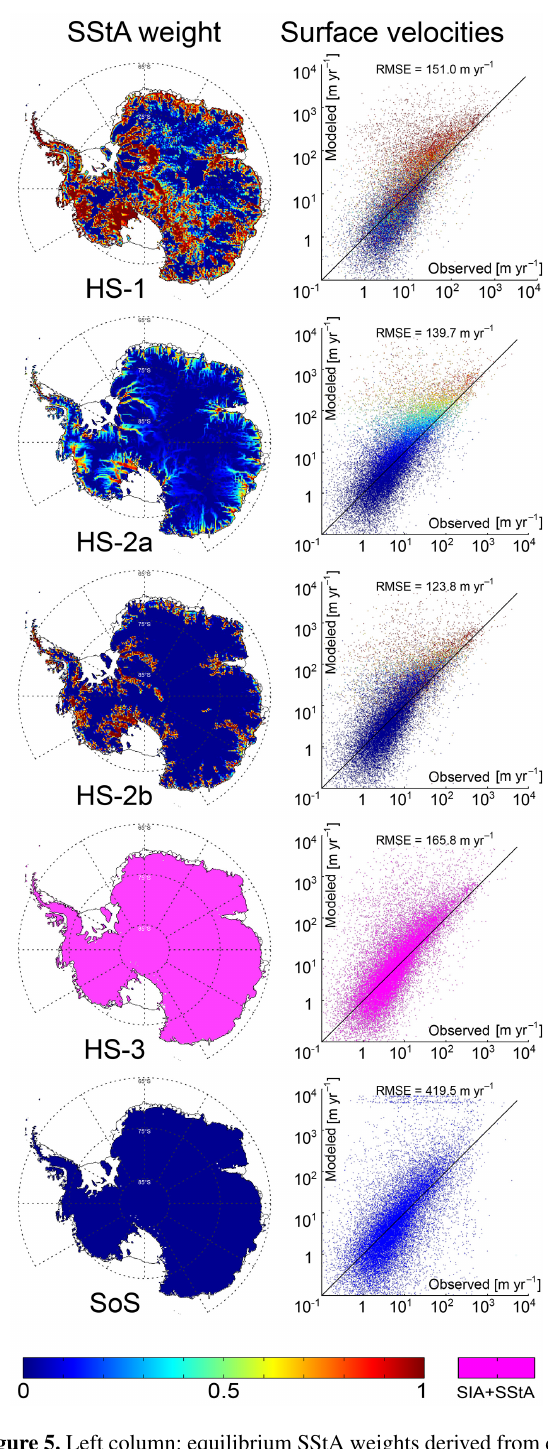
Figure 5. Left column: equilibrium SStA weights derived from dif- ferent schemes. The HS-3 does not use a weighting function and simply adds velocities derived from both shallow approximations. Right column: scatter plots of modelled vs. observed surface veloc- ities, in myr − 1 . Each point is colour-coded according to the corre- sponding SStA